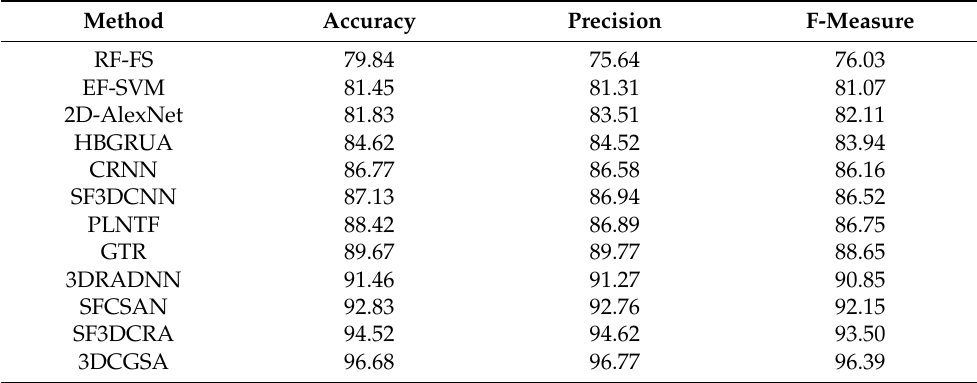
Table 1. Stress recognition results using the DEAP dataset.